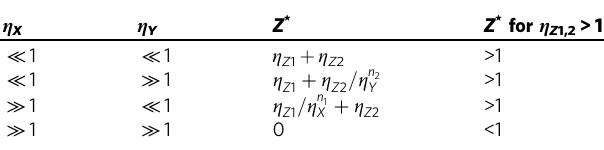
Table 1 NAND Logic function for two repressors based on Eq.